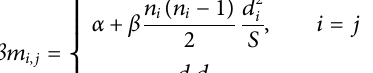
are Λ intra edge groups and ( Λ